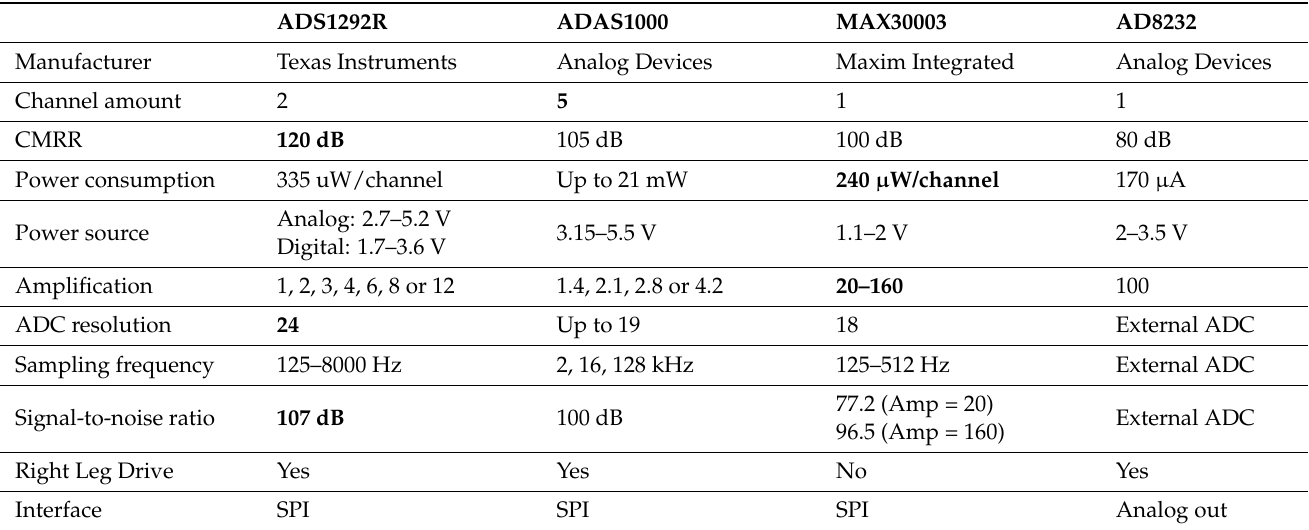
Table 1. Comparison of the main characteristics of analyzed analog